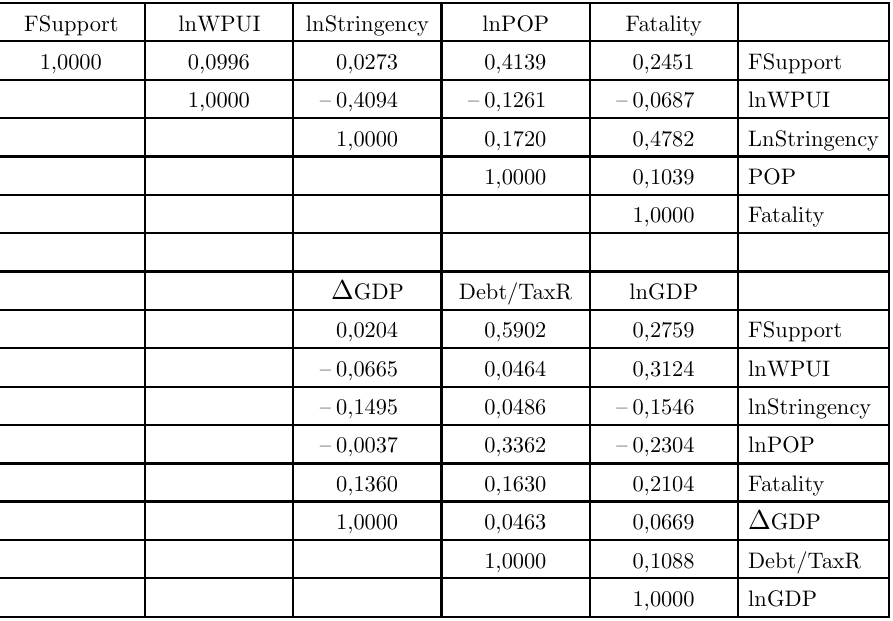
Correlation matrix